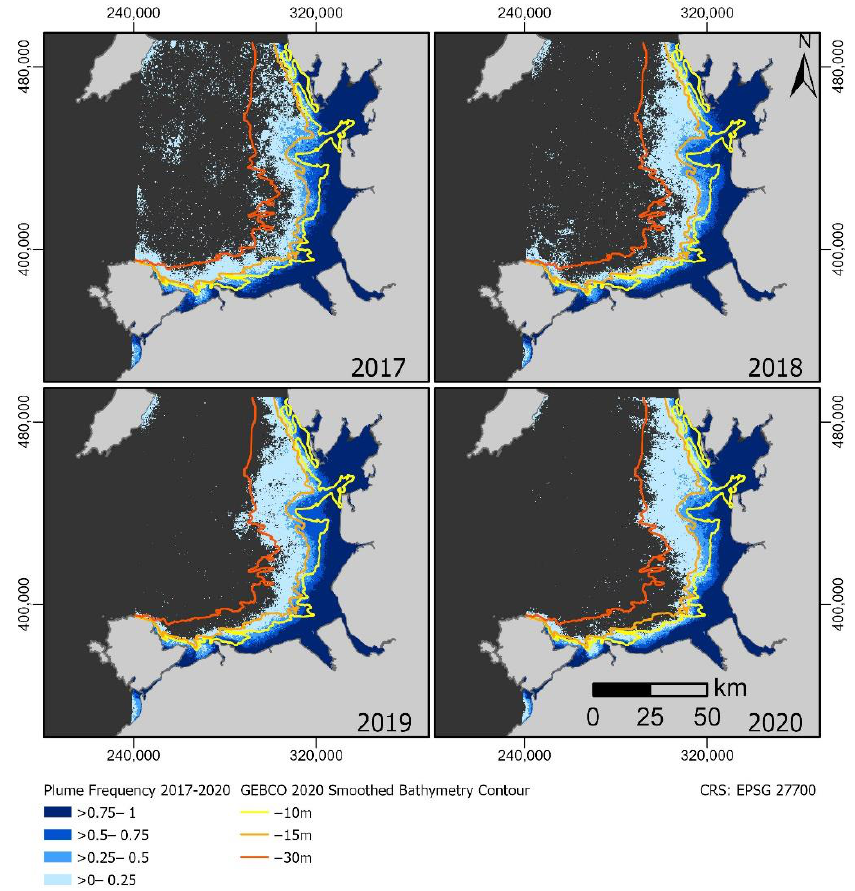
Figure 4. Yearly plume frequency in the Liverpool Bay. The plume frequency 1 denotes the pixel was marked as plume in all the months within the year. The mapped river plume corresponds to the Coastal, Near-Shore and Estuaries waterbodies (FUI ≥ 10) [21] and Primary plume (FUI ≥ 10) wet season class from [11]. The source of bathymetry is: GEBCO Compilation Group (2020) GEBCO 2020 Grid doi:10.5285/a29c5465-b138-234d-e053-6c86abc040b9, accessed on 1 February